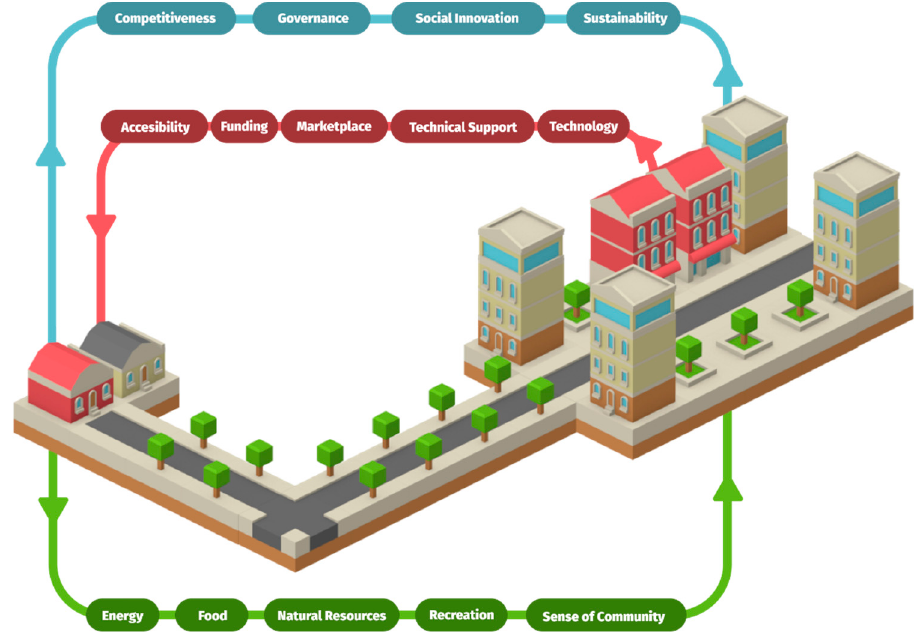
Figure 1. Smart and Sustainable Rural ‐ Urban Linkages (Own elaboration).